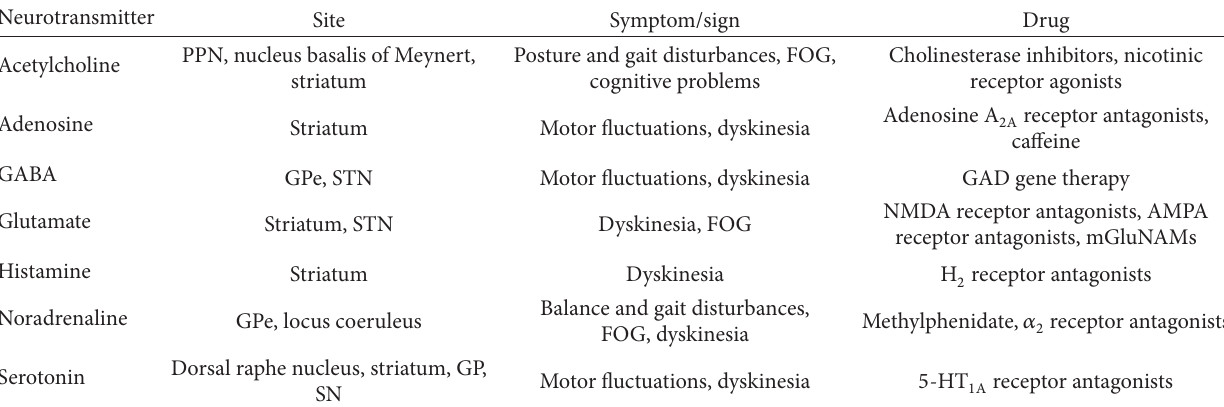
Table 2: Nondopaminergic neurotransmitters involved in the pathogenesis of Parkinson’s disease and pharmacological agents potentially active or tested to counteract their